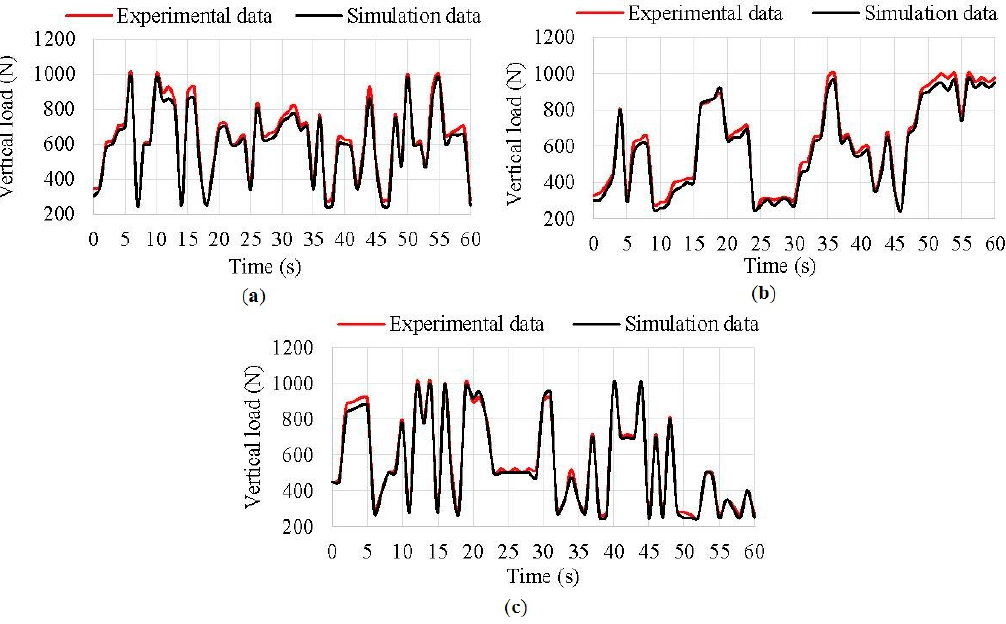
Figure 16. ( a ) Vertical load simulation results at 0.8 bar; ( b ) Vertical load simulation results at 1 bar; ( c ) Vertical load simulation results at 1.2 bar.